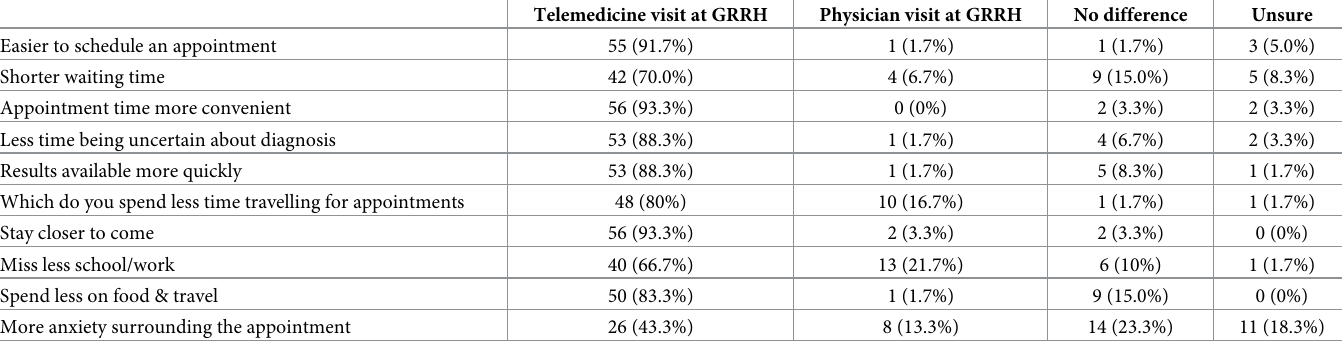
Table 4. Preferences for type of care